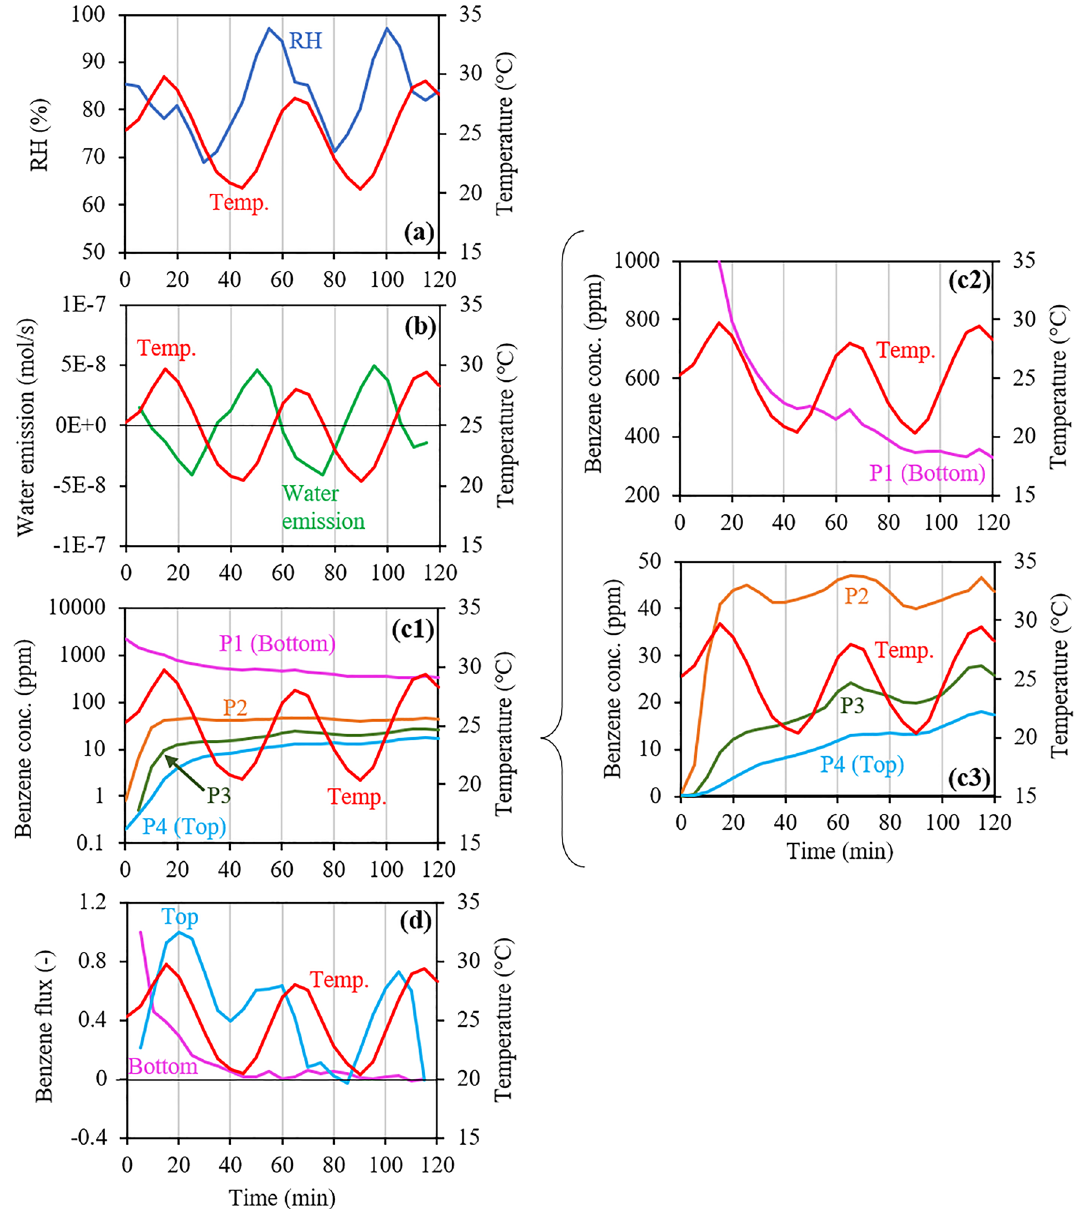
Figure 3. Changes in ( a ) relative humidity (RH) and ( b ) corresponding water emission, ( c1 – c3 ) benzene concentrations at the four ports (P1–P4), and ( d ) bottom and top benzene fluxes estimated from the concentration changes at P1 and P4, respectively, in Run 2 under dynamic temperature (20 ‒ 30 °C). Note that the flux value at each time is represented by a ratio of the observed value at each time to the largest observed in the concentration gradient cause the enhanced flux changes and the inverse relationship between changes in flux and temperature, was demonstrated only in part, which suggests that changes in the concentration gradient that were responsible for the bottom and top flux changes occurred more locally. Figure 5 shows the changes in the RH, water emission, PCE concentrations at P1 ‒ P4 with correspond- ing lower and upper concentration differences, and bottom and top PCE fluxes in the dynamic temperature experiment (Run 3), where the largest absolute values in the bottom and top fluxes were 1.6 × 10 –6 mol/m 2 /s and 5.5 × 10 –9 mol/m 2 /s, respectively. For this experiment, the only difference between the experimental conditions and those in Run 2 was essentially the change in the VOC type to PCE, having a stronger temperature depend- ency in volatility (Supplementary Figure S1b). In general, the results for Run 3 were qualitatively similar to those in Run 2. However, the changes in concentration with temperature changes were more evident, and the top flux changes were more intense, whereby a much larger negative flux occurred. This is consistent with the findings of a previous study 31 that flux changes in response to temperature changes were larger for TCE than benzene,